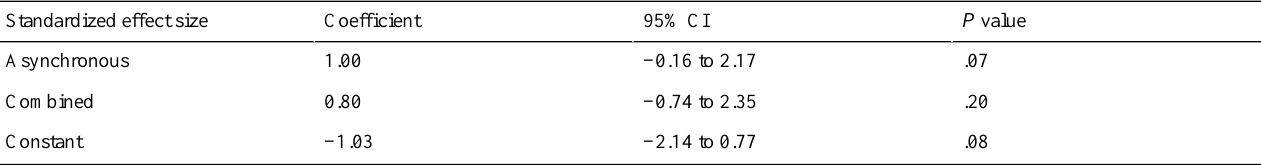
Table 5. Metaregression of synchronous and asynchronous interventions on fatigue outcome, analyzed using standardized effect size.